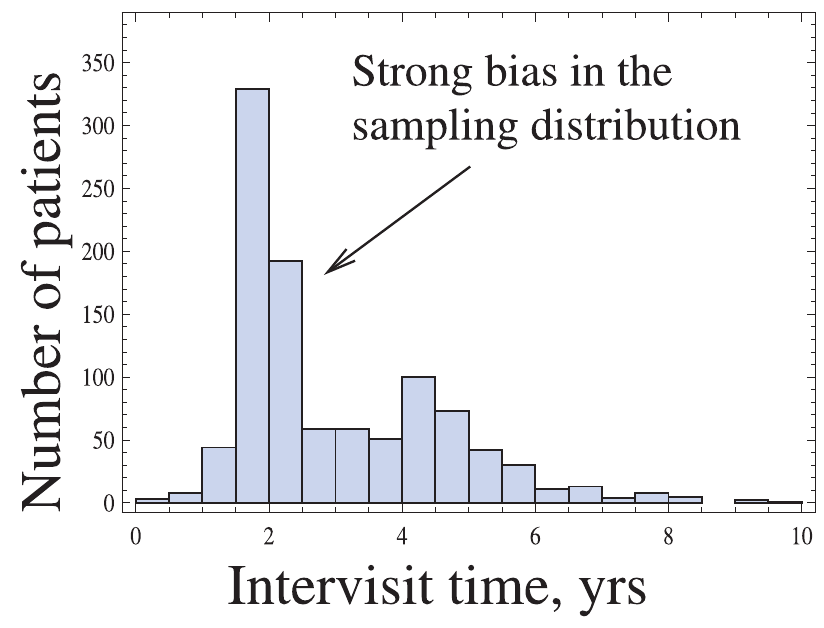
Figure 7. Real-life AD dataset: a strong bias in the sampling distribution.